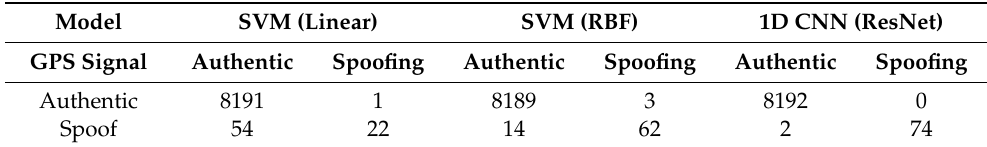
Table 5. Confusion matrix of SVM and 1D CNN.